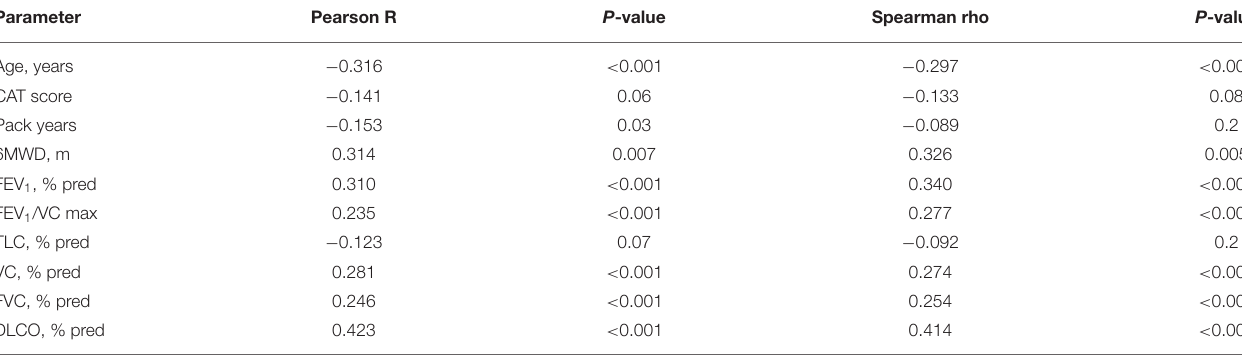
TABLE 2 | Correlations with the TAPSE/PASP ratio in patients with COPD without pulmonary hypertension.